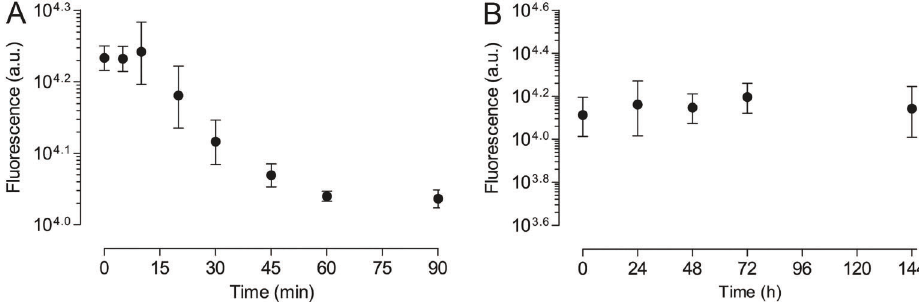
Figure 4. Nile red (NR) fl uorescence stability. A. brasilense strain FP2 was grown until reaching OD 600 of 1.4. PHB measurements were performed using the optimized procedure, as described in the Materials and Methods. A , After resuspension of cells in TBAC buffer, NR fl uorescence was monitored during 90 min by fl ow cytometry. B , Samples were stored at 4°C in permeabilization solution (TBAC buffer containing 50% of EtOH), until analysis, as indicated. For analysis, samples were stained with NR (31.25 m M) during 1 min, centrifuged (1 min at 13,400 g ), resuspended in TBAC buffer and analyzed immediately by fl ow cytometry. Fluorescence data (arbitrary units, a.u.) are reported as means ± SD of 3 independent experiments with H. seropedicae strain SmR1 and A. brasilense strain FP2, by using the median fl uorescence intensity values in the FL2-H